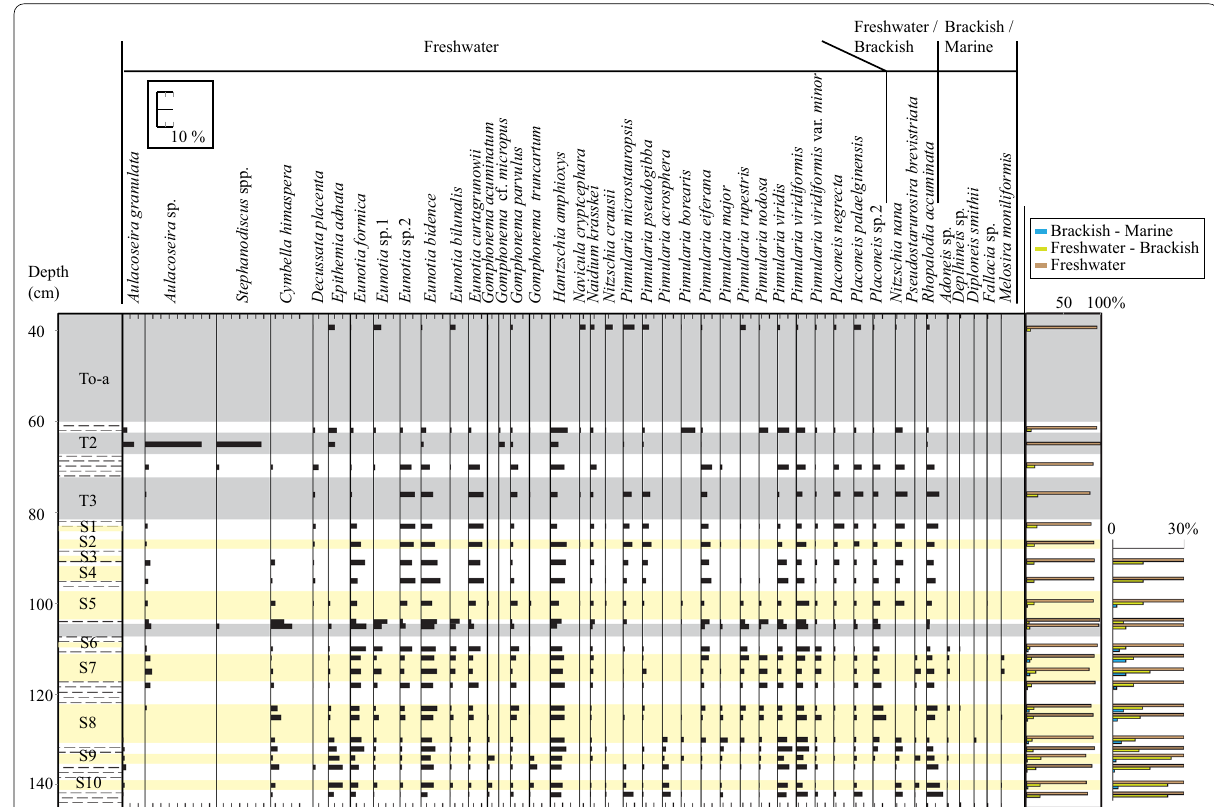
Fig. 10 Diatom analysis result for the core sample Ha 8. In the horizontal axis are described the diatom species found along with the sediment core: freshwater, freshwater–brackish, and brackish–marine environments. On the right side, diatom‑origin proportion is described as a percentage. A close view depicts the presence of marine species (from 0 to 30%)